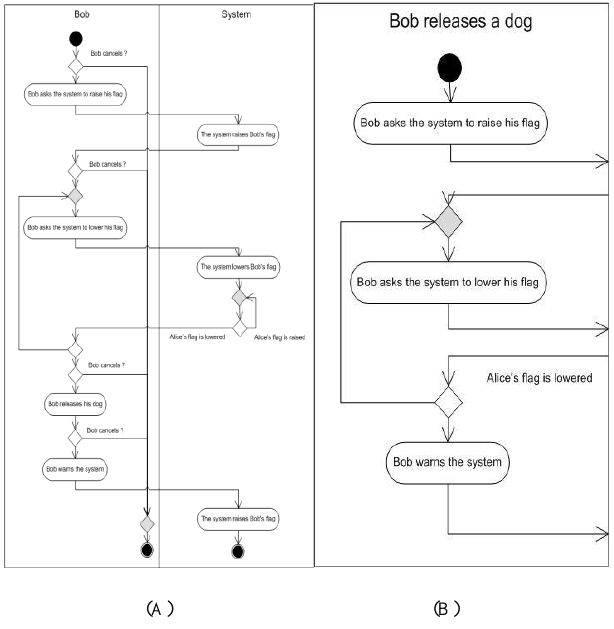
Figure 9 . IOD corresponding to the use case “Bob releases a dog” and System